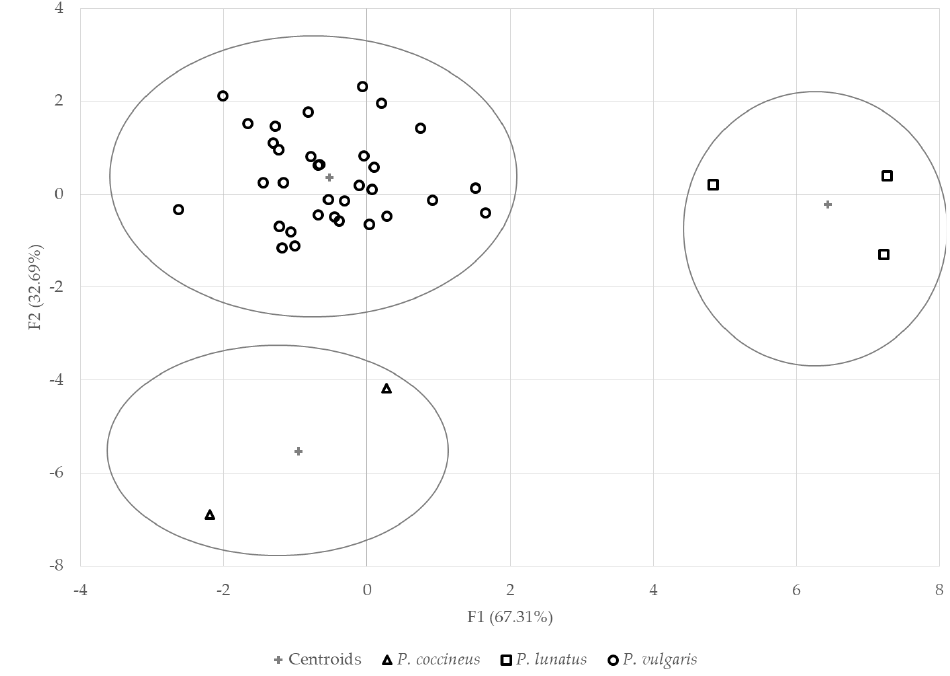
Figure 3. Discriminant amino acid analysis (essential and non-essential). Table 3. Total phenolic, flavonoid, anthocyanin, tannin, phytic acid, oligosaccharide, lectin, trypsin inhibitory activity, and radical scavenging activity from Phaseolus accessions